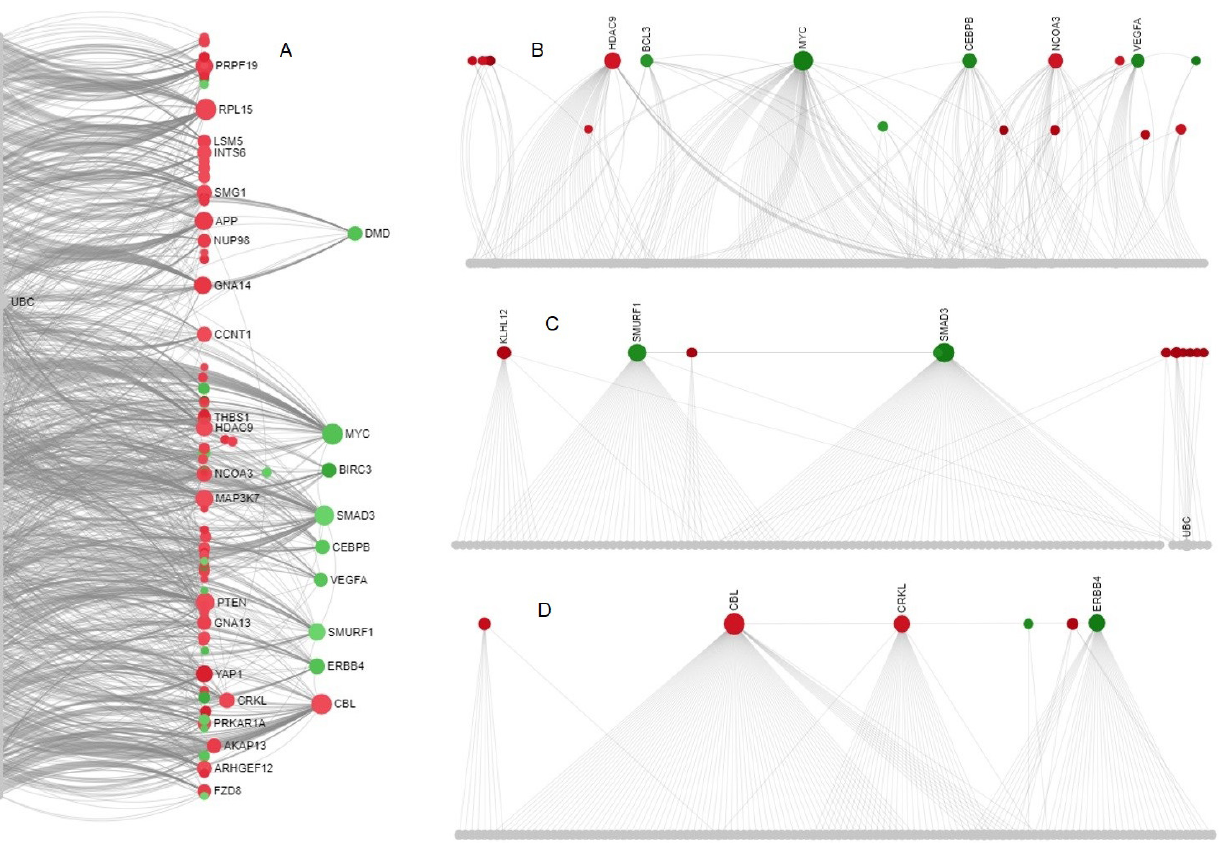
Figure 2. PPI network and Walk trap modules from DE-CoV-HGs. ( A ) PPI network with highly interconnected nodes; ( B ) Module-1; ( C ) Module-2; ( D ) Module-3. Overexpressed genes are represented in green color, under-expressed genes in red color, interconnected nodes in gray